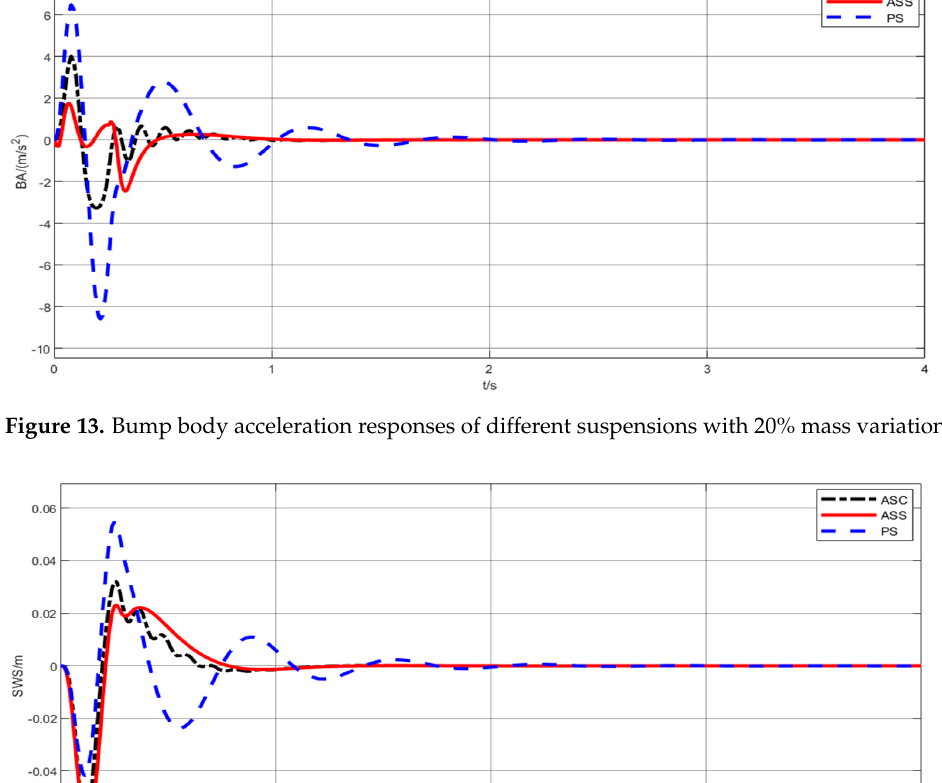
Figure 15. Bump dynamic tire displacement responses of different suspensions with 20% mass variation. 5. Conclusions A constrained robust H ∞ controller of active suspension system for IWMD-EV con- sidering control constraint and parameter variation is proposed. Parameter uncertainties in the active suspension system model are analyzed, and control constraints of suspension performance for constrained robust H ∞ controller design are also investigated. Simula- tions, including random and bump road excitations, are implemented to verify the effec- tiveness of the proposed controller. It is confirmed from the simulation results that the designed controller possesses improved ride comfort and road-holding ability perfor- mance in spite of control constraints and parameter variations. Moreover, this study also reveals that the potential of an active suspension system for IWMD-EV can be improved by developing robust control strategies. In the future, we will further research and com- pare various control techniques for other active suspension systems with different topol- ogy structures in IWMD-EV. Besides, we will explore and extend the applicability of the developed control method in other different areas, such as vehicle lateral dynamics and integrated vehicle handling and stability. Author Contributions: Conceptualization, X.J., J.W., S.S., J.Y., Z.Y.; supervision, X.J.; conception and design, X.J., J.W., S.S.; collection and assembly of data, X.J., J.W., J.Y.; manuscript writing, X.J., J.W.,